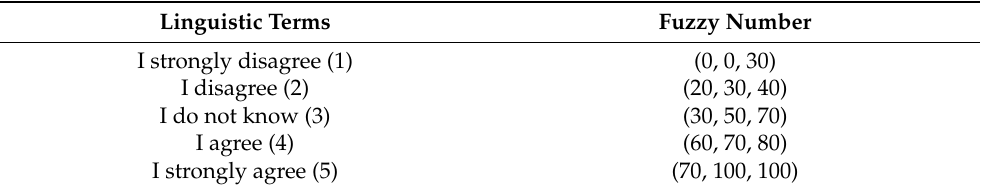
Table 3. Triangular fuzzy numbers. Default values of linguistic terms. Linguistic Terms Fuzzy